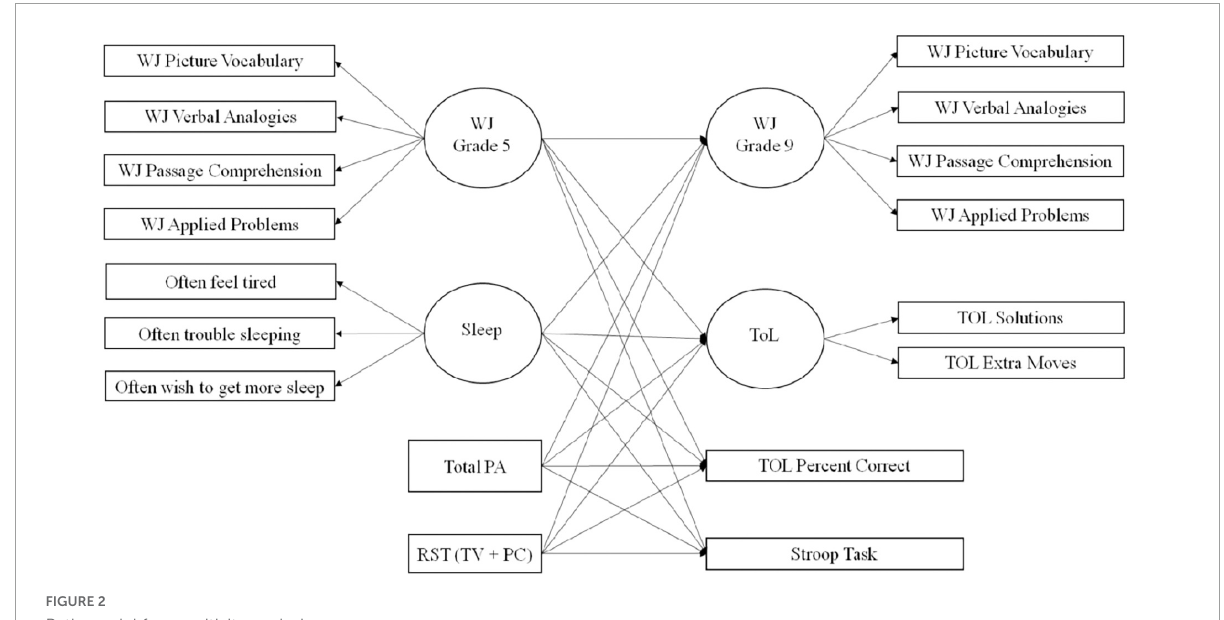
FIGURE2 Path model for sensitivity